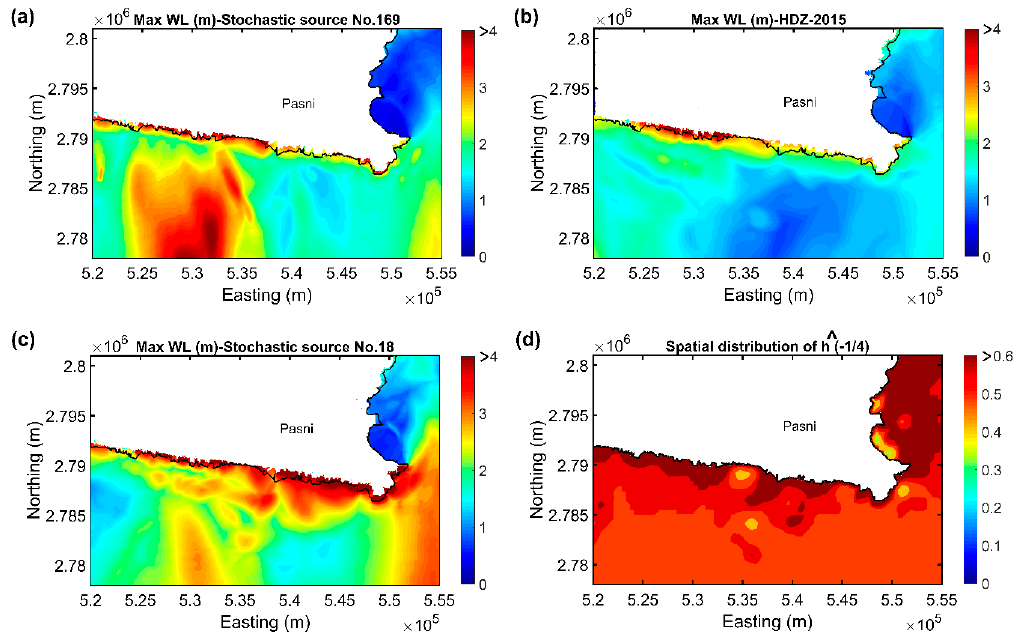
Figure 12. Maximum wave height near Pasni based on: ( a ) the best matching stochastic model 169 for the 1945 event, ( b ) the HDZ-2015 model, and ( c ) 97.5th-percentile stochastic model 18. ( d ) Spatial distribution of h − 1/4.